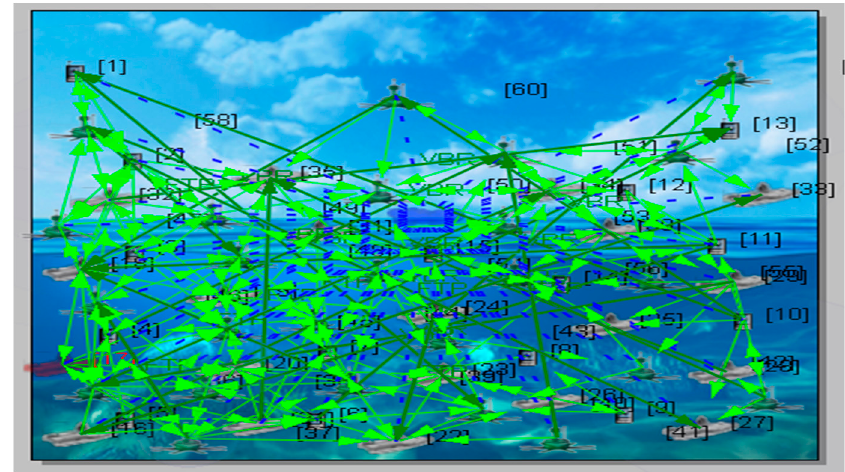
Figure 4. Proposed scenario of underwater wireless communication in X-Y visualization .